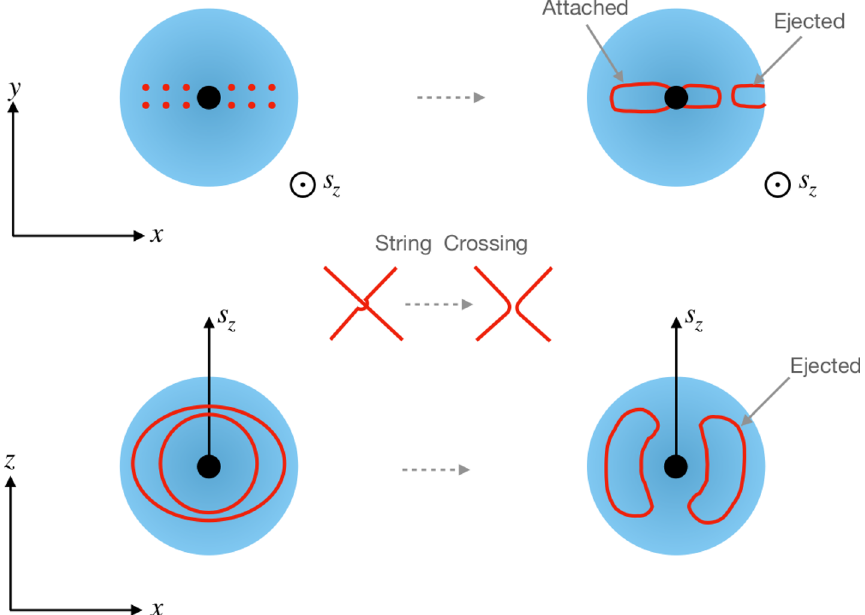
Figure 13 . An illustration of how the dynamics of crossings (middle panel) affect the motions string vortices in a dark photon cloud that arose through superradiance around a spinning black hole. Vortices (red dots and lines) form in the dark photon superradiance cloud (blue shaded region) around a spinning black hole (black dot) with spin direction s z . Upper panel ( x − y plane): initially parallel strings in the vortex lattice exchange partners with each other, leading to strings that attach to the black hole at different longitudes as well as strings that are ejected. Lower panel ( x − z plane): a different configuration where string loops spanning a longitudinal line exchange partners with each other, forming loops that can be ejected from the superradiance